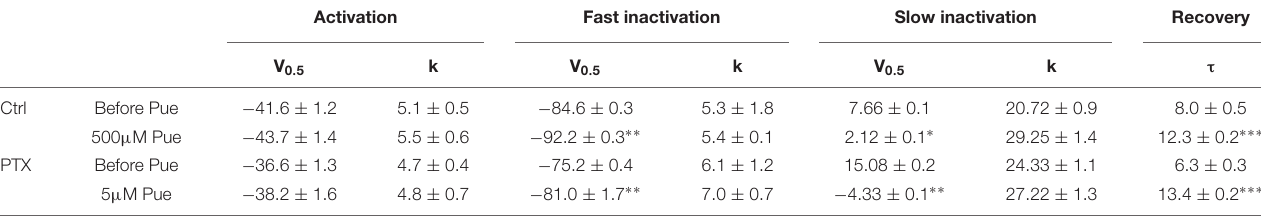
FIGURE 6 | The effects of puerarin on activation, inactivation and recovery of Na v channels in DRG neurons at corresponding IC 50 concentrations (Ctrl, control; PTX, paclitaxel; Pue, puerarin). (A,B) Puerarin does not affect the activation curves of Na v channels in control (A) and paclitaxel (day 10) (B) group ( n = 10 neurons in each group). (C–F) The peak Na + current ( I Na ) was normalized to the maximal value ( I Na , max ) and plotted against the conditioning pulse potential. The inactivation curves indicated that puerarin accelerated the inactivation of Na v channels in two groups ( n = 6–10 neurons in each group). (G,H) Puerarin slowed down the recovery from the inactivation of Na v channels in each group ( n = 10 neurons in each group). The detailed parameters of analysis are shown in Table 3 . TABLE 3 | Parameters for Na v channels activation, inactivation, and recovery in DRG neurons. Activation Fast inactivation Slow inactivation